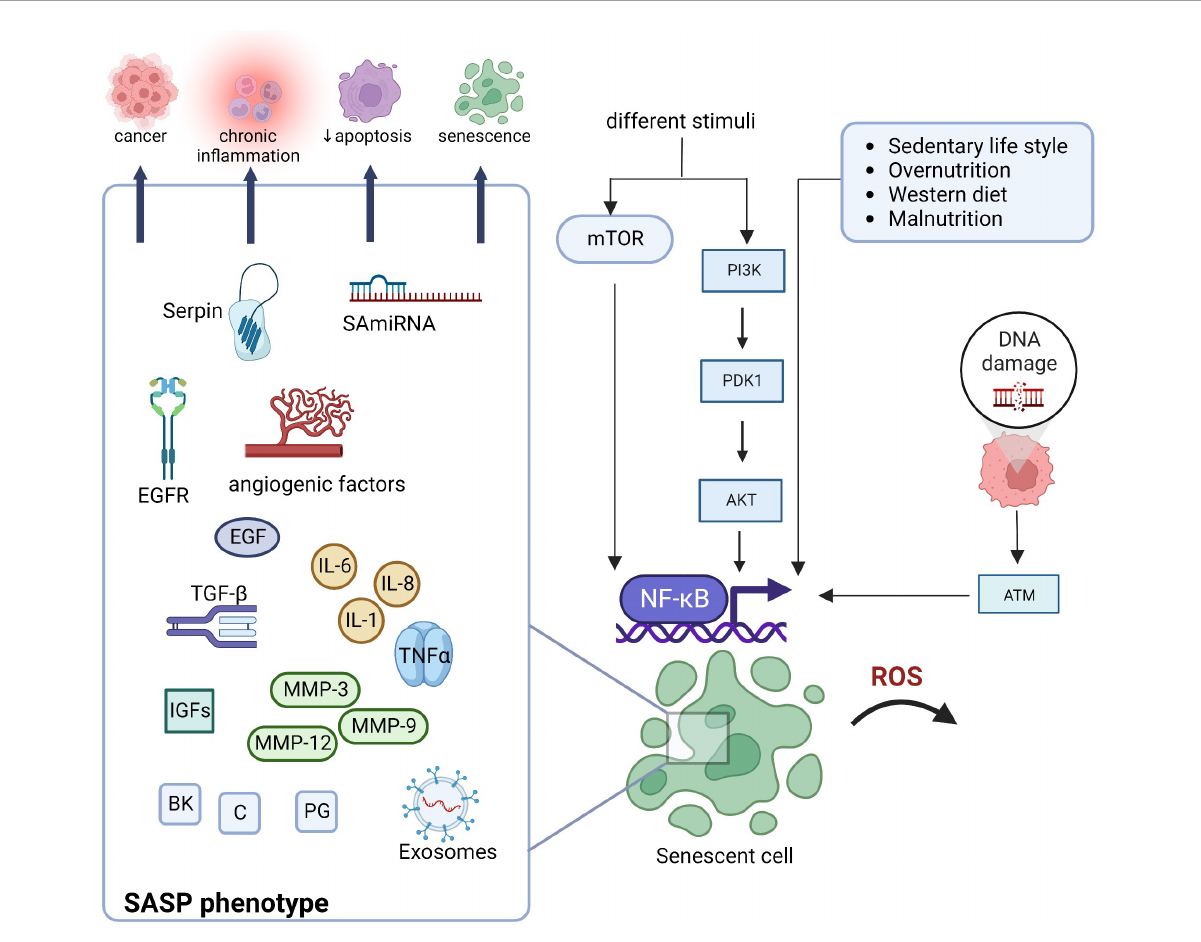
FIGURE1 Schematic representation of main regulatory pathways activated in SCs (NF-kB, through mechanistic target of rapamycin -mTOR, and PI3k/Akt pathways) and production of proinflammatory and matrix-degrading mediator characteristics of SASP. SASP is related to increased chronic inflammation and other aging-associated conditions. Akt, protein kinase B; ATM, ataxia-telangiectasia mutated; BK, bradykinin; C, ceramides; EGF, epidermal growth factor; EGFR, epidermal growth factor receptor; IGFs, insulin-like growth factors; IL, interleukin; MMP, matrix metalloproteases; mTOR, mammalian target of rapamycin; NF-kB, nuclear factor- κ B; PDK1, phosphoinositide-dependent kinase; Pi3K, phosphoinositide 3-kinases; PG, prostaglandin; SA-miRNA, senescence-associated microRNAs; TGF, transforming growth factor; TNF, tumor necrosis factor; ROS, reactive oxygen species. Created with